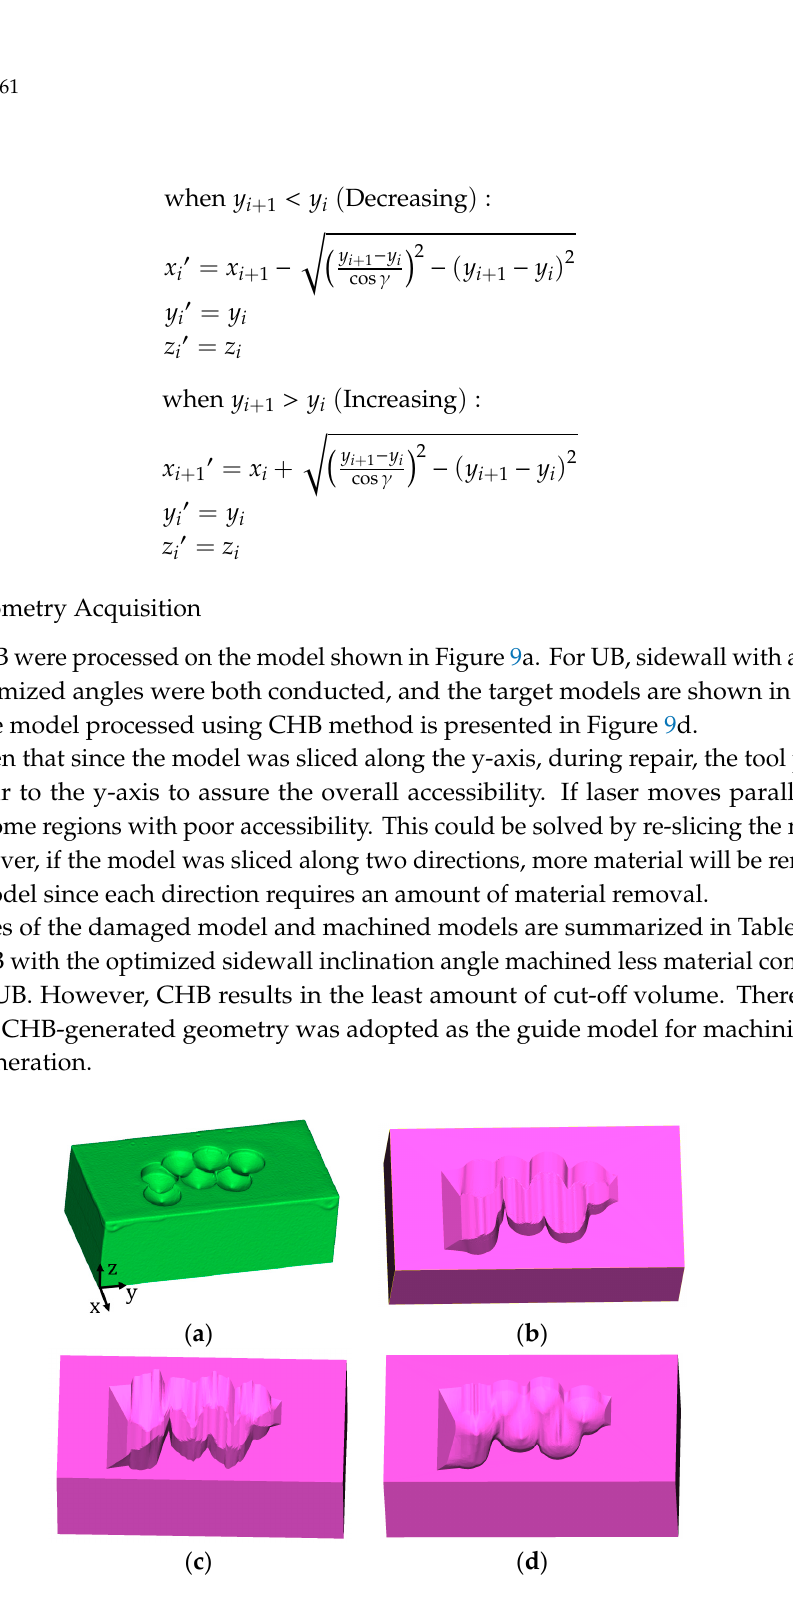
Figure 9. Damaged and machined models. ( a ) Damaged model; model machined using the UB method without optimization ( b ) and with optimization ( c ); ( d ) model machined using the CHB method. Table 1. The volume of the damaged and machined models.